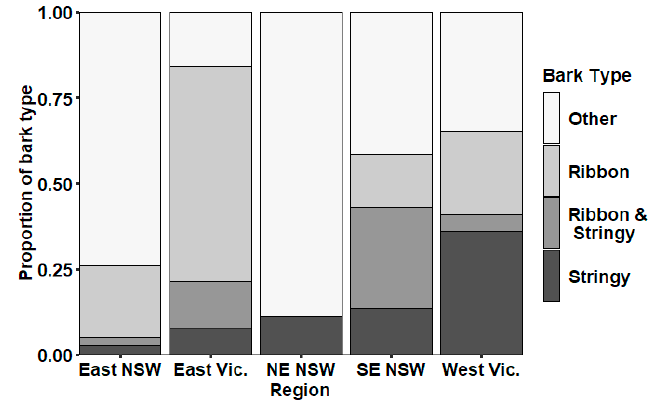
Figure 12. Proportion of di ff erent bark types by region. Sampled from source fire areas for each region.